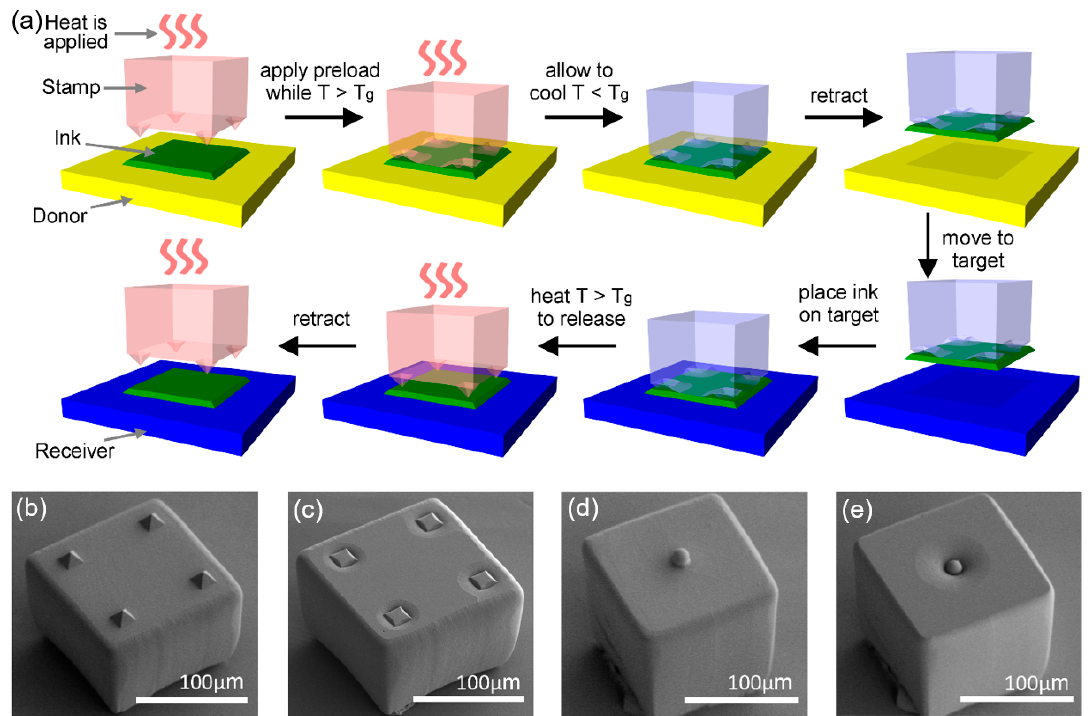
Figure 4. ( a ) Implementation of a shape memory polymer (SMP) microtip stamp for transfer printing. ( b ) Microtip stamp in permanent, “adhesion OFF” state. ( c ) Microtip stamp in temporary “adhesion ON” state. ( d ) Silica-sphere stamp in permanent “adhesion OFF” state. ( e ) Silica-sphere stamp in temporary “adhesion ON” state. Reproduced with permission from [53].